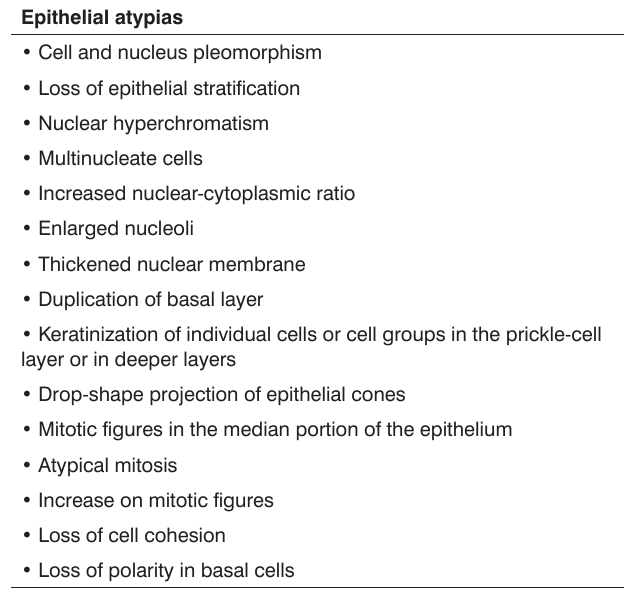
Table 2. Histological diagnostic criteria for epithelial dysplasia.